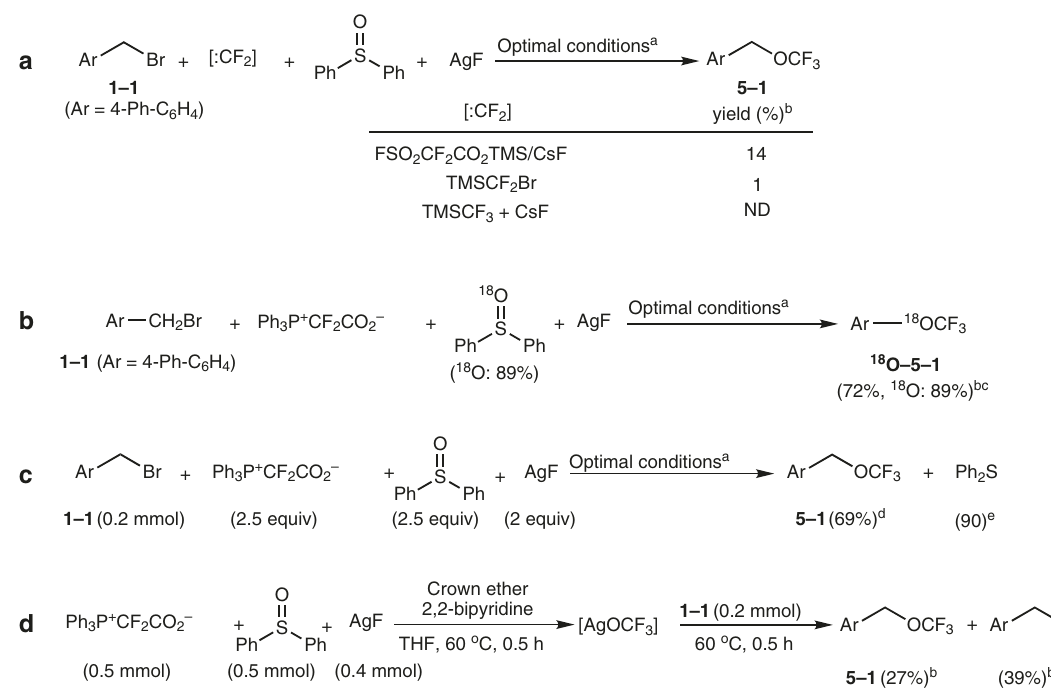
fi rmation of the AgOCF a The optimal conditions are shown as 2 S. d The con 3 complex. = O 2 S